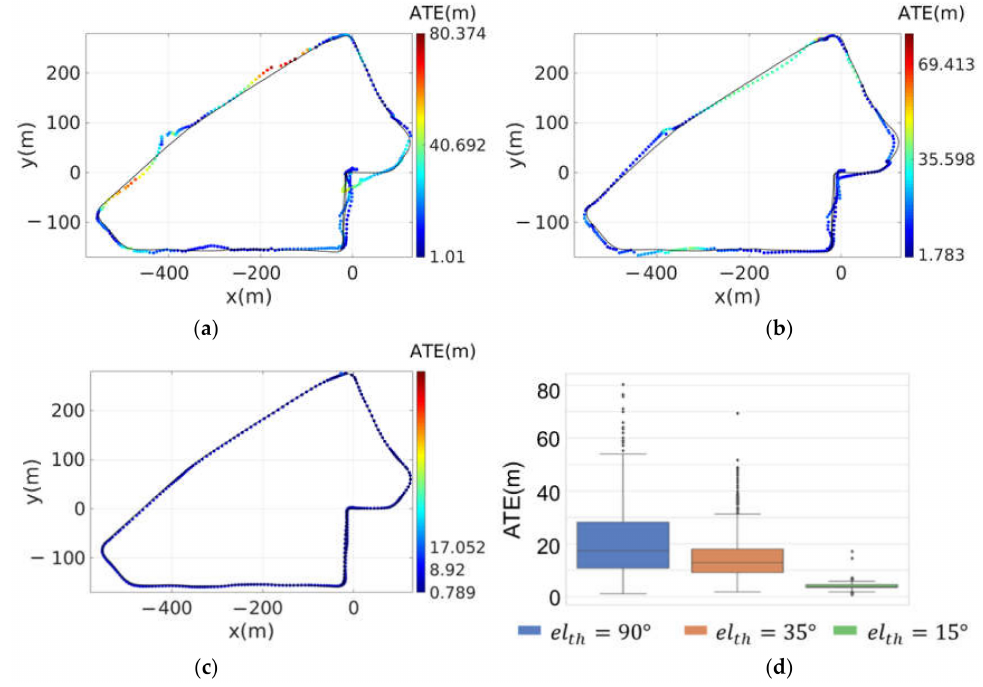
Figure 7. ( a – c ), plots the trajectory generated by pipelines with the thresholds el th for the GNSS-RTK availability assessment set as 90 ◦ , 35 ◦ , and 15 ◦ respectively on urban-1. The black trajectory is the ground truth. The ATE of each estimated position is mapped on the trajectory referring to the color bar with the same scale on the right, on which the largest and the smallest tick label represent the maximum and the minimum ATE respectively while the middle one represents the midrange of them. ( d ) shows the boxplot of the ATE on the whole trajectory produced by the pipelines with three different